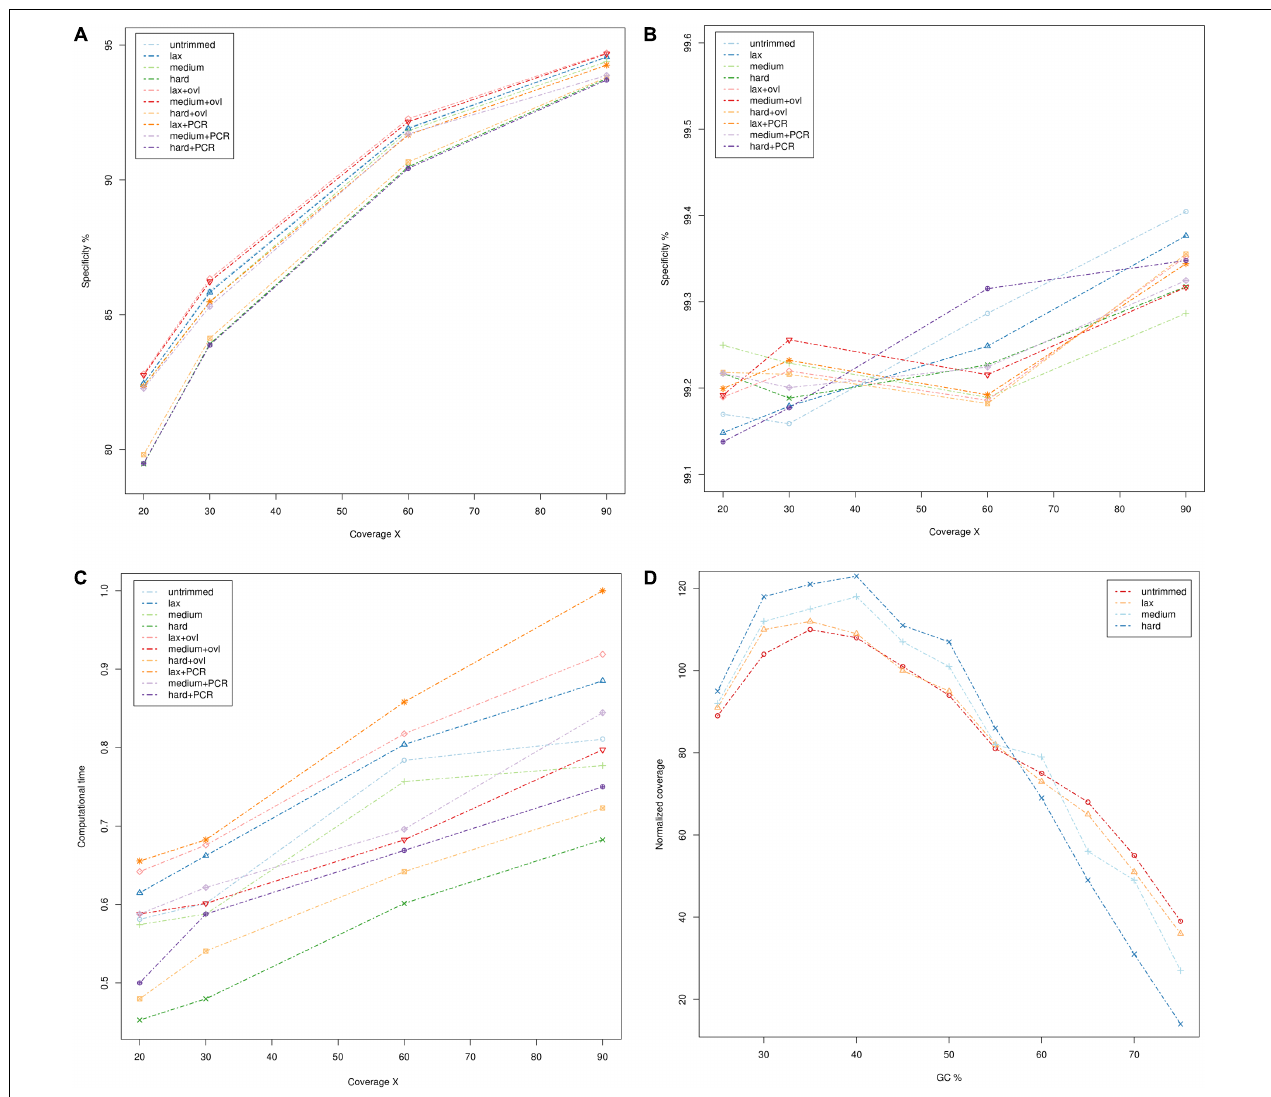
FIGURE 2 | Comparison of quality assessment pipelines on Whole Exome Sequencing data. (A) Sensitivity of quality assessment pipelines at different levels of coverage. (B) Specificity of quality assessment pipelines at different levels of coverage. (C) Computation time required by the pipelines. Times reported have been scaled with unity-based normalization. (D) Normalized coverage levels with respect to GC composition. Coverage levels and GC composition were calculated on genomic windows of 200 bp, overlapping by 100 bp. Coverage levels were normalized using the upper-quartile normalization and scaled to 100 (where 100 represents the expected